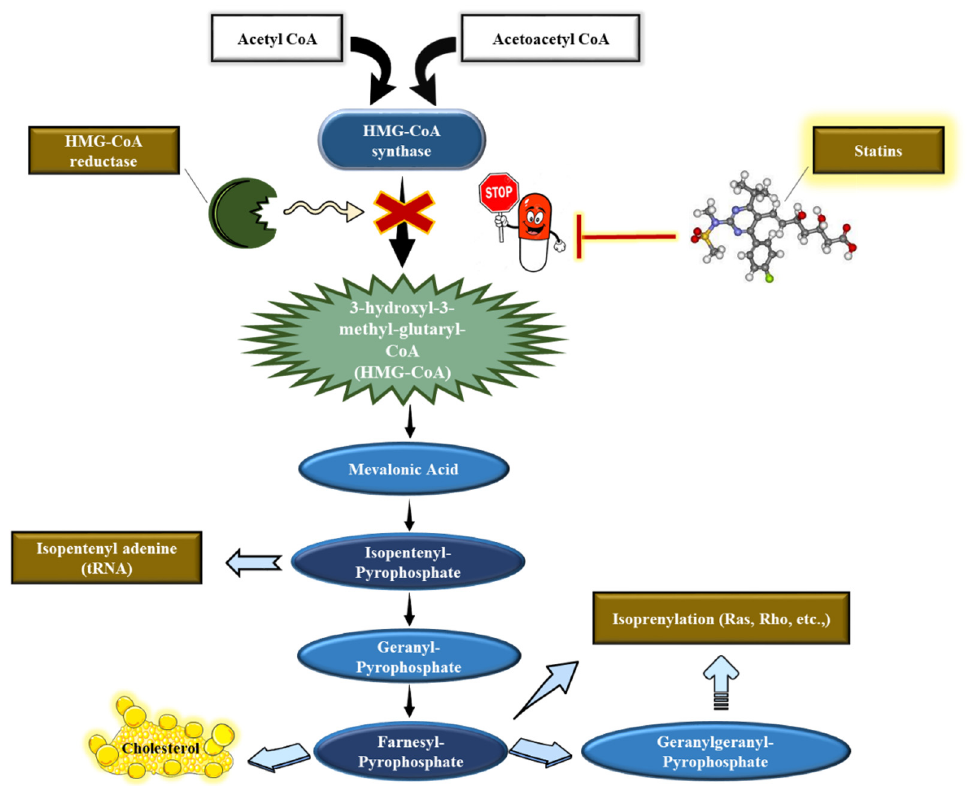
Figure 2. Statins’ mechanism of action. Statins inhibit the HMG-CoA reductase to block the synthesis of mevalonic acid and, consequently, the production of cholesterol.